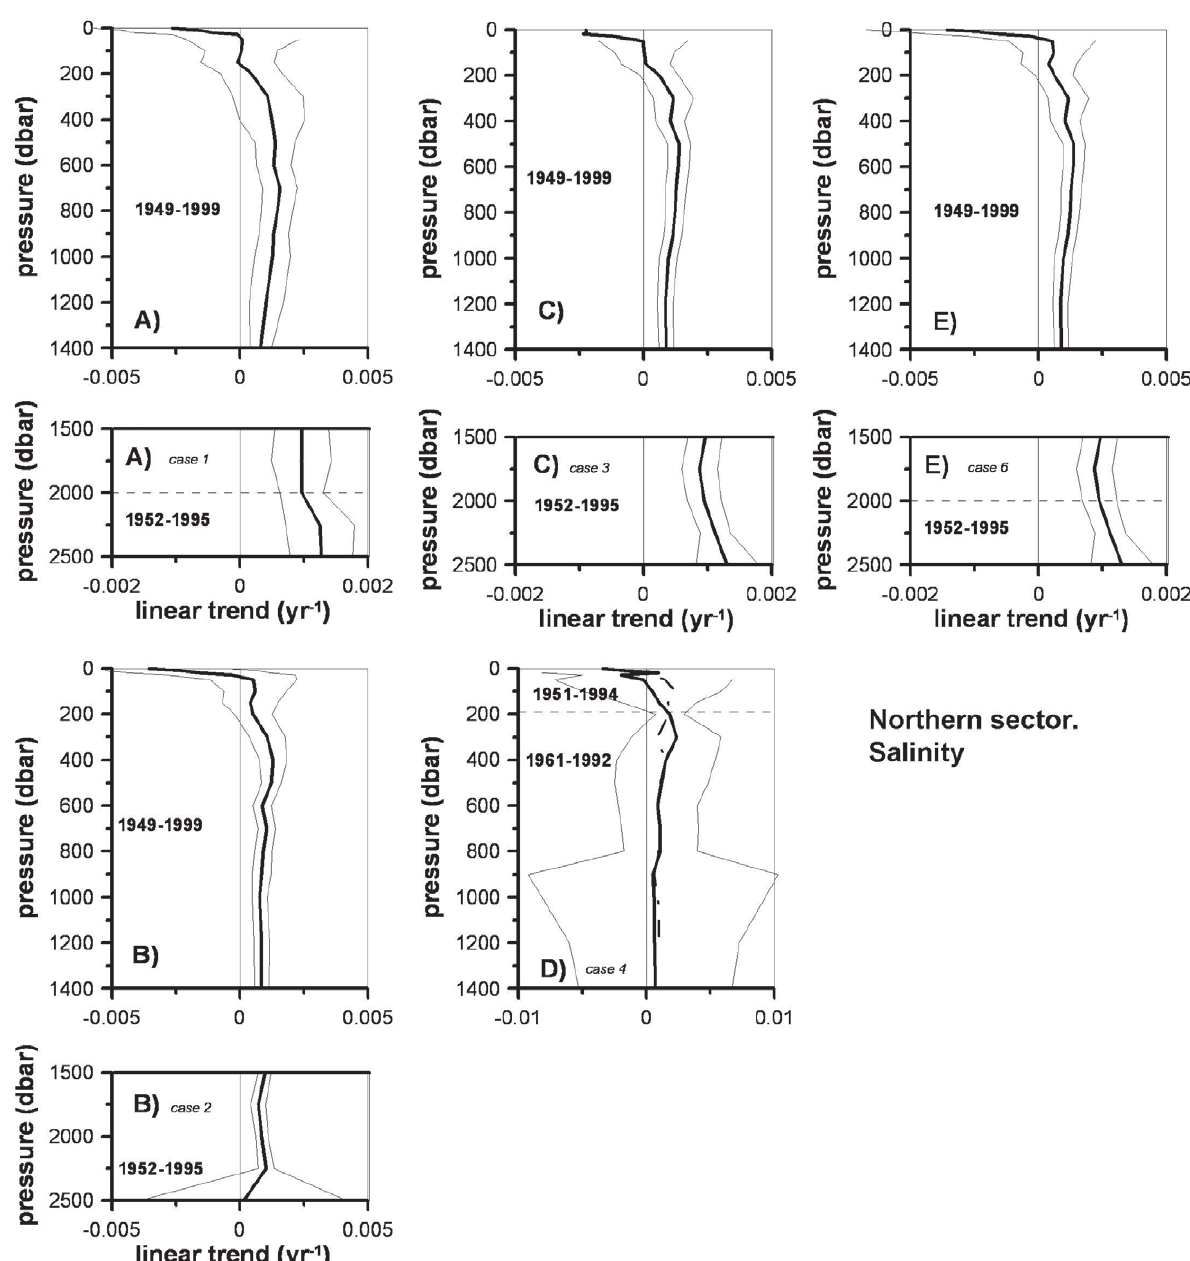
Fig . 11. – salinity trends for the northern